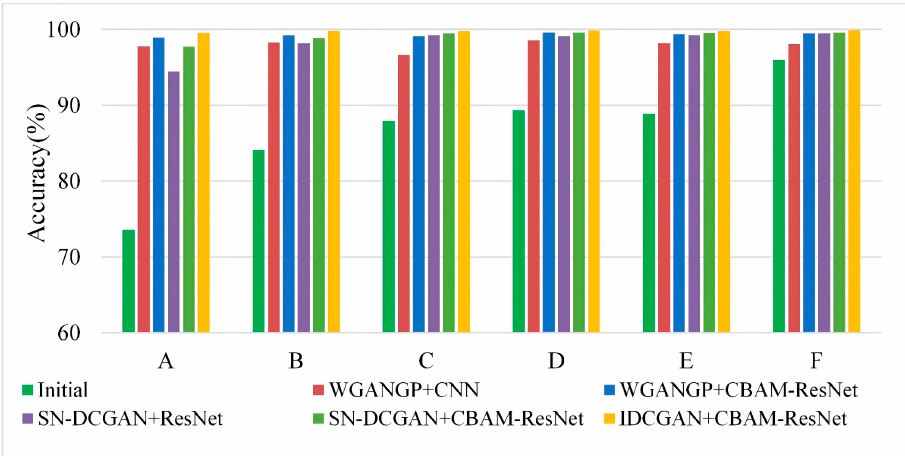
Figure 16. Experimental results based on multi-class imbalanced data. The t-SNE visualization results of high-dimensional features learned by different classifiers with different augmented training data are shown in Figure 17. The results are obtained based on the same experiment as case 1. It is clear that the feature clusters between different samples cannot be well distinguished with initial imbalanced data. The feature cluster boundaries of different classes based on CBAM-ResNet and expanded balance data are much clear than those of the CNN and ResNet, indicating the strong feature extraction ability of the proposed CBAM-ResNet. Besides, the feature clusters become compact and there is almost no overlap, meaning that the proposed IDCGAN has a strong sample generation ability and is superior to the generative methods used for comparisons. From the above, it can be concluded that the fused time-frequency feature based on the multi-signal fusion method is beneficial to provide more valuable information.